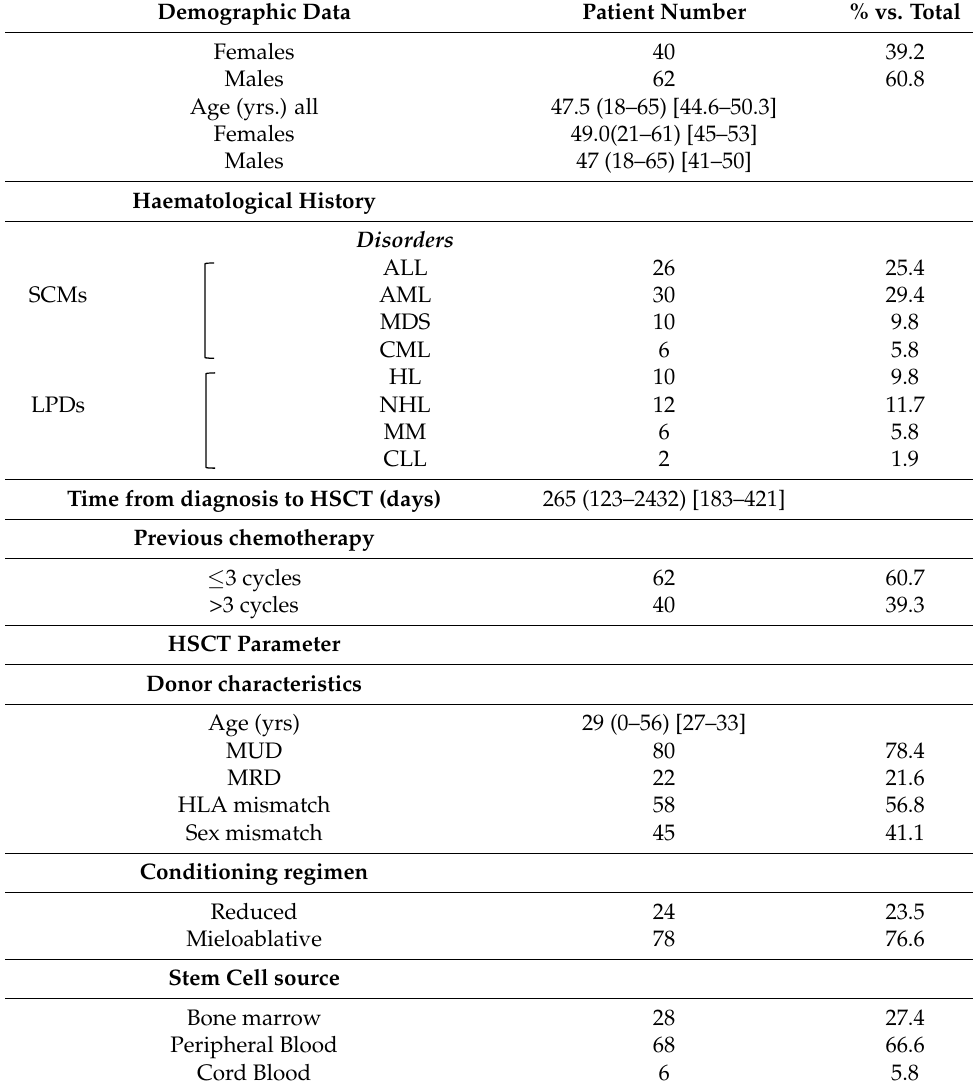
Table 1. Clinical and demographic data in subjects included in the study. Data are expressed as median (min-max values) (95%